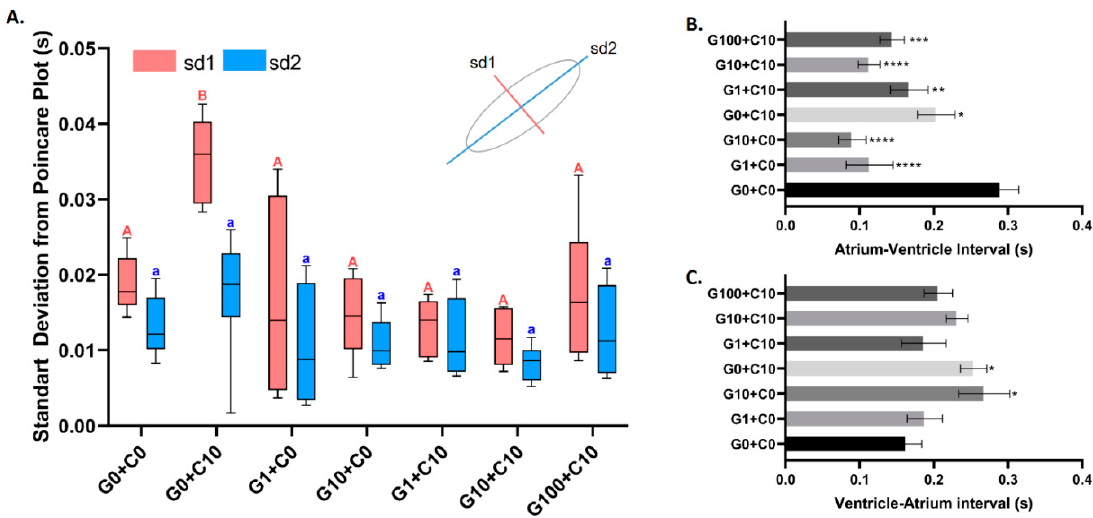
Figure 5. Sd1 and sd2 data generated from Poincare plot ( A ) and the time interval between the atrium and the ventricle chamber contractions, respectively ( B , C ), to compare the heartbeat variability in zebrafish embryos after being treated with di ff erent GHK tripeptide and copper combinations. The data were analyzed statistically using one-way ANOVA, with p < 0.05. Di ff erent labels above the shaded box indicate statistical significance. G = GHK (nM), C = CuSO 4 (nM). G0 + C0 was used as a control group. G1 + C0 and G10 + C0 were used as GHK function test groups. G0 + C10 was used as a cardiotoxicity group raised by copper exposure. G1 + C10, G10 + C10, and G100 + C10 were used as cardiotoxicity rescue groups. In each tested group, the sample size was between 10 and